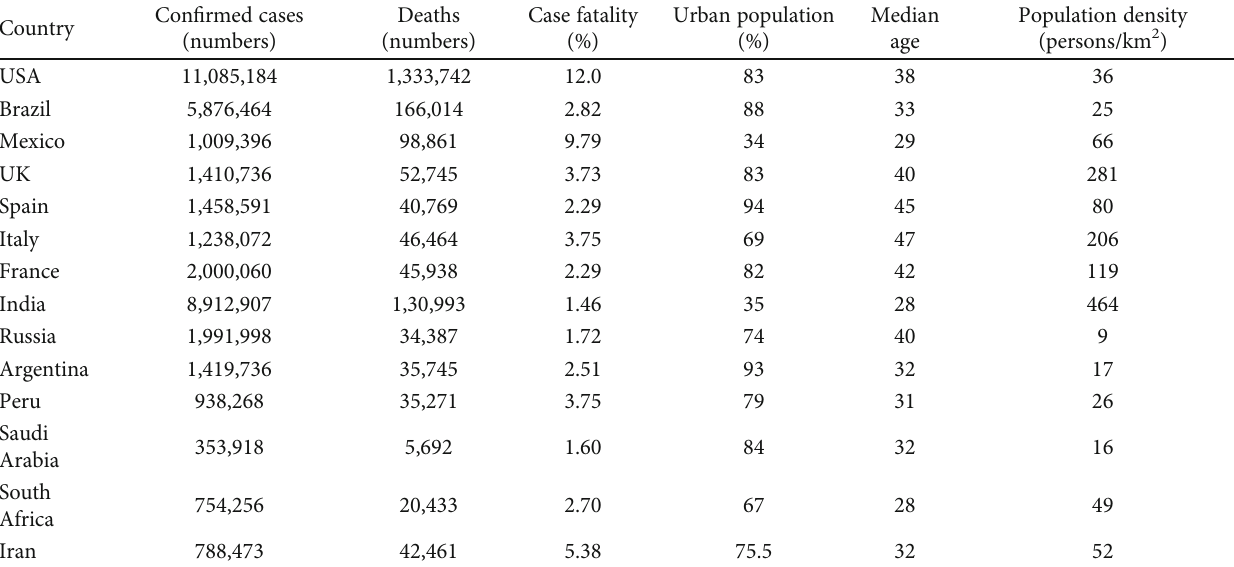
Table 1: Con fi rmed and death cases of SARS-CoV-2 from di ff erent countries of the world. The rate of SARS-CoV-2 mortality compared with the death rate, population density, urban population, and median age group of countries. India with the highest population density (464 persons/km 2 ) shows the least mortality (1.4%) with the median age group of 28 years as per data on 19 November 2020 (https://www .worldometers.info/ and